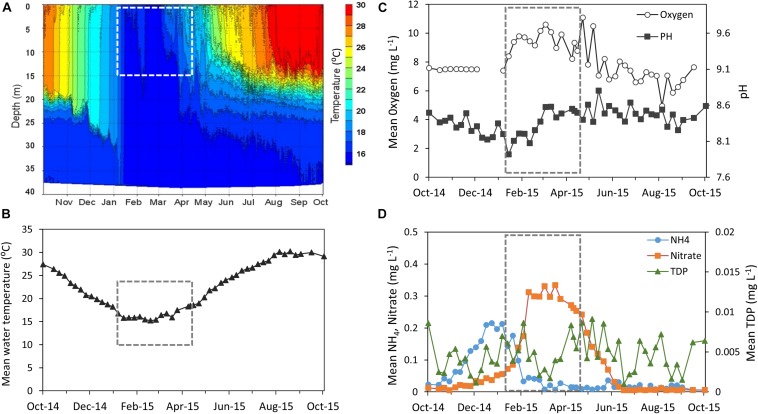
Abiotic conditions measured over the hydrologic year 2015 (October-14 to October-15) (Supplementary Table S1). (A) Changes in water temperature as a function of depth. (B–D) Physical and chemical measurements of the photic layer (depth average of 0–15 m): (B) water temperature (°C). (C) Oxygen (mg L–1) and pH (D) Ammonia, Nitrate, and total dissolved Phosphate (TDP) (mg L–1). The study period is framed by a dashed line. Data were obtained from the Lake Kinneret data center (IOLR), courtesy of Dr. W. Eckert, Dr. Y. Beeri-Shlavin, and M. Shlichter (Kinneret Limnologic Laboratory, IOLR).